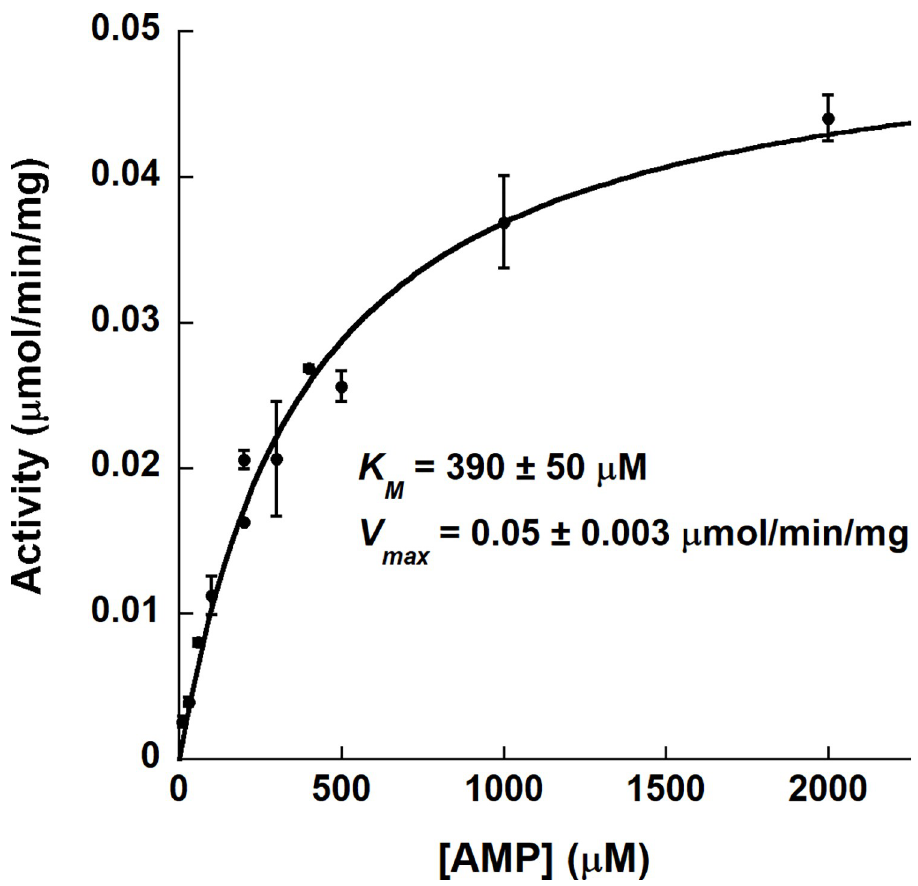
Fig 5. Catalytic activity of K . pneumoniae Amn. The activity of KpAmn was measured by quantifying the generation of the product, adenine. The initial rate data at varying concentrations of AMP was fit by the Michaelis-Menten equation to yield the kinetic constants